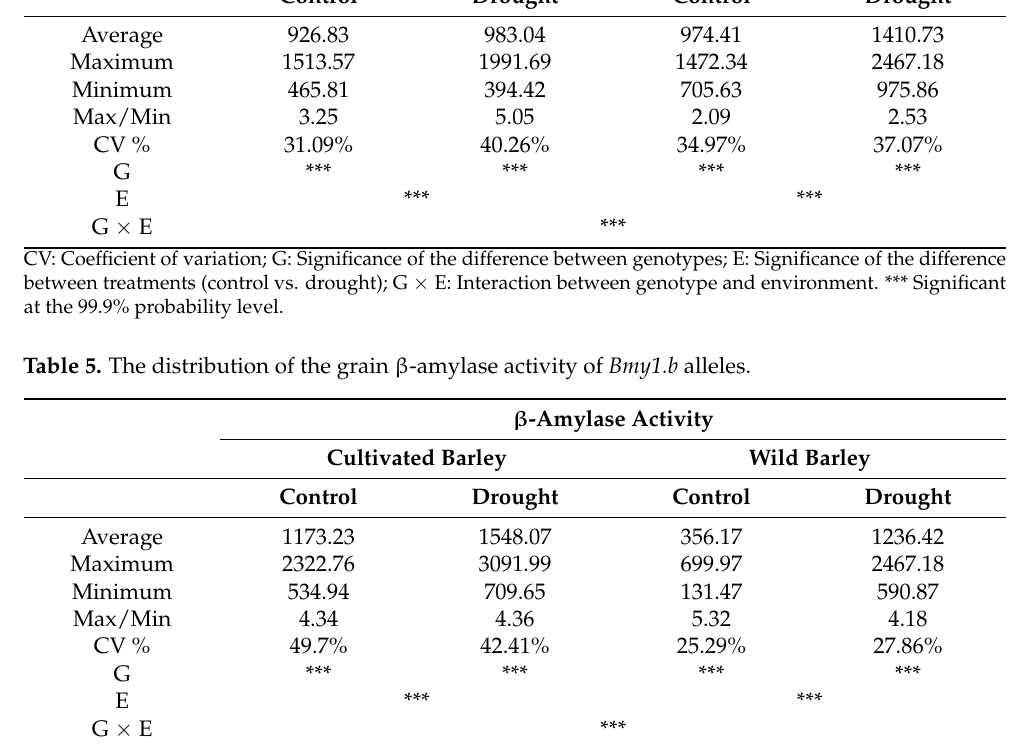
Table 6. The distribution of the grain β -amylase activity of Bmy1.c alleles.